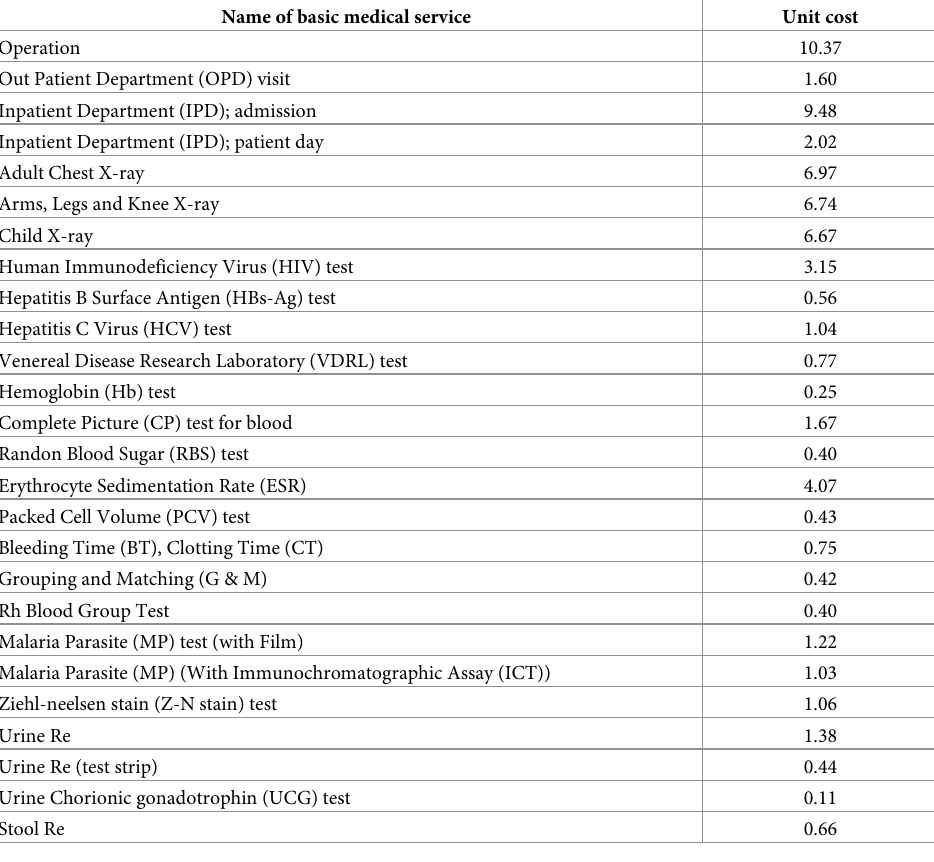
Table 2. Unit cost of medicals (USD in 2015